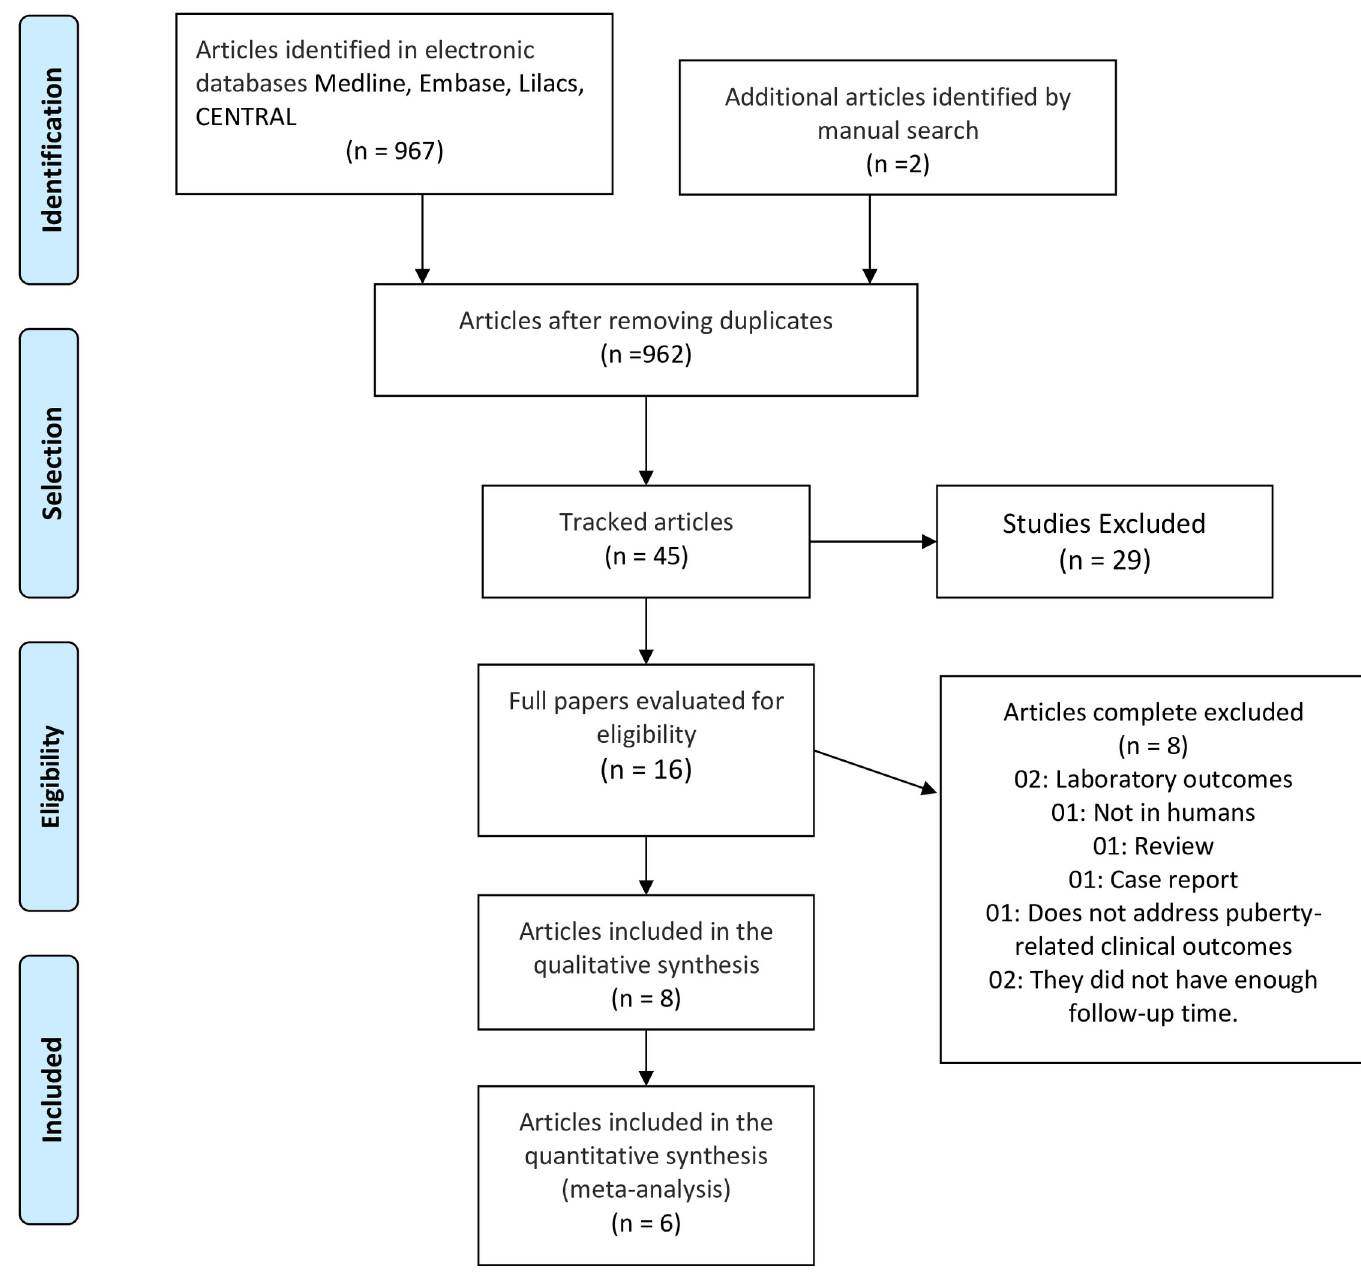
Fig 1. Flow diagram of the selection of